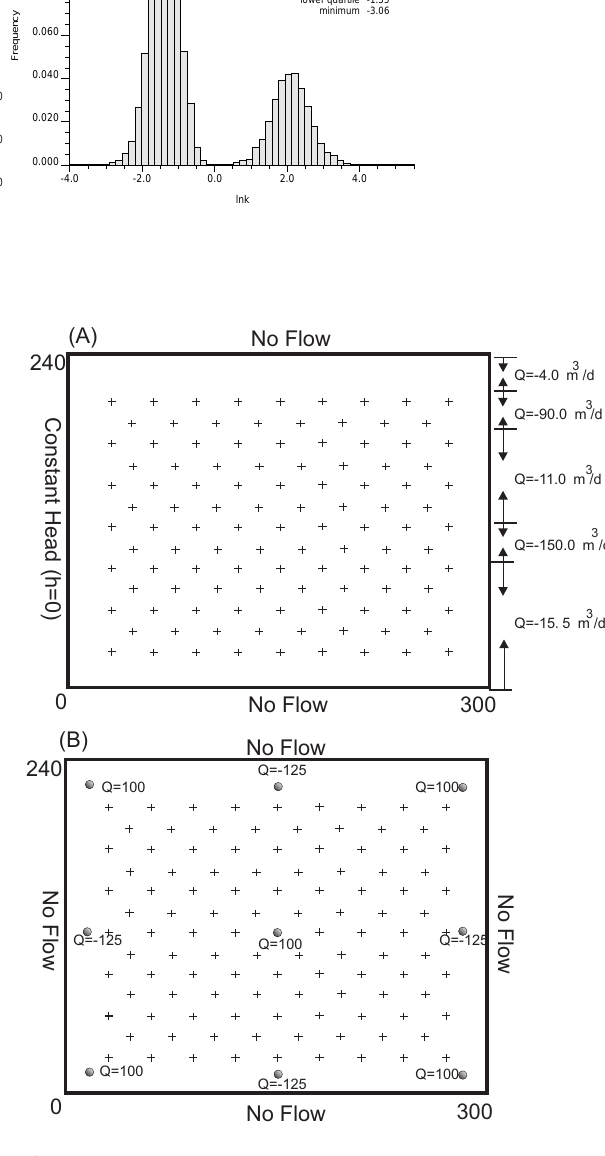
Fig. 3. Spatial distribution of sampled head data and flow configurations: (A) Parallel flow (B) Radial flow (the unit of flow in wells: m 3 / d ).